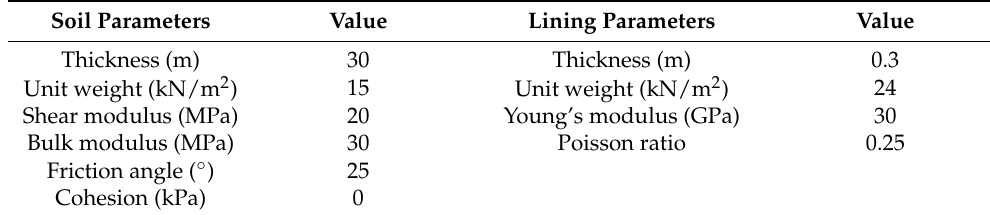
Table 1. Summary of the soil and tunnel parameters.